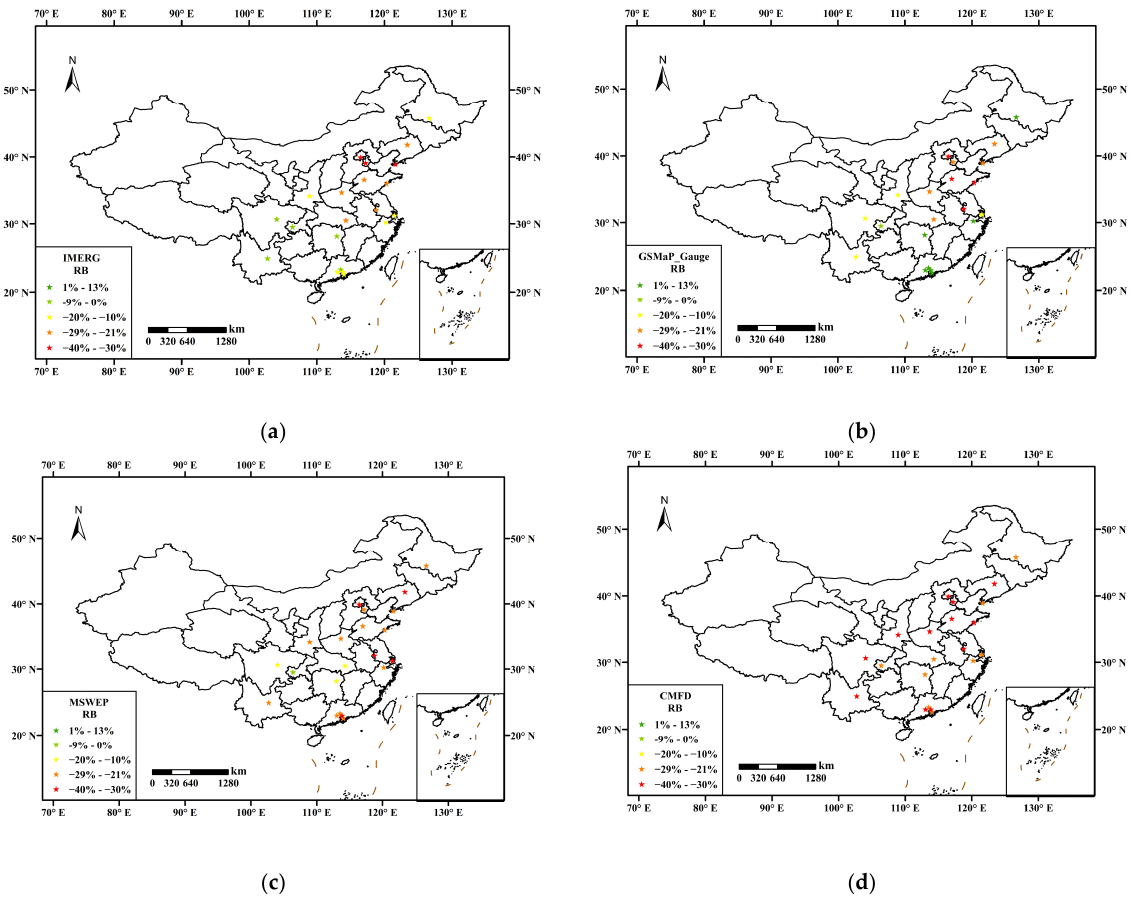
Figure 7. The relative bias between R99 values of SPPs data and rain gauges in 21 major cities:( a ) IMERG, ( b ) GSMaP_Gauge, ( c ) MSWEP, and ( d ) CMFD.